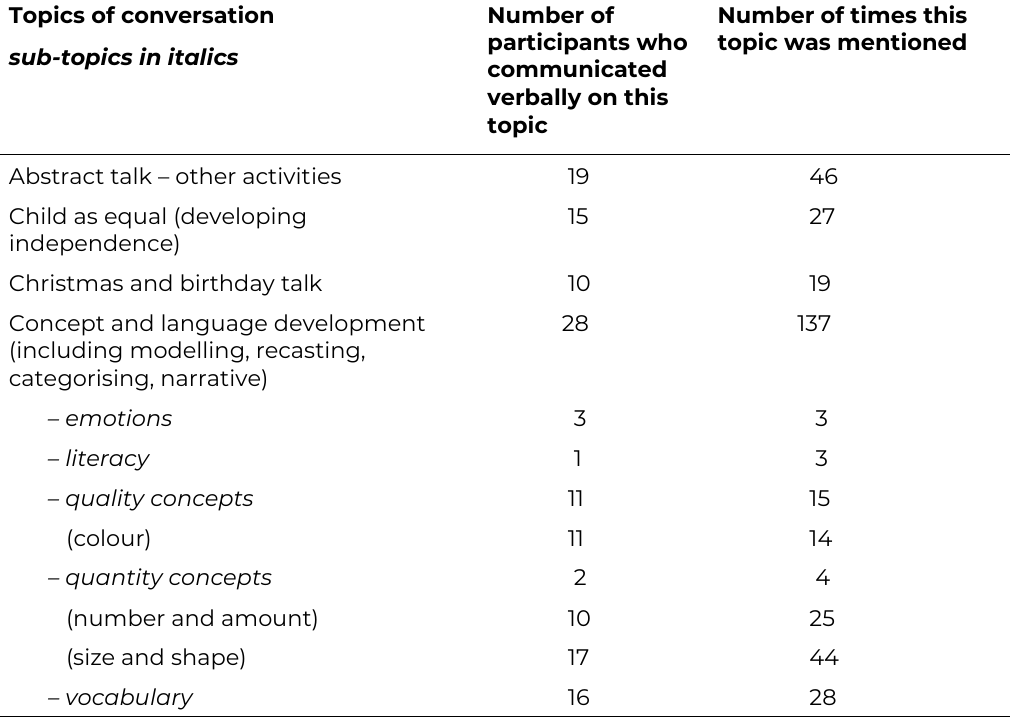
Table 1. Codes for topics of conversation between the educators and children Topics of